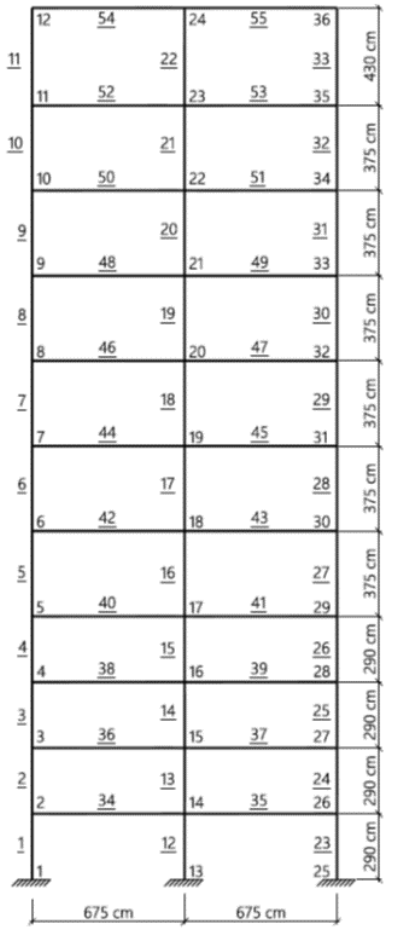
Figure 6 – Frame with eleven stories and two spans: Dimensions and numbering. Source: Authors (2020)